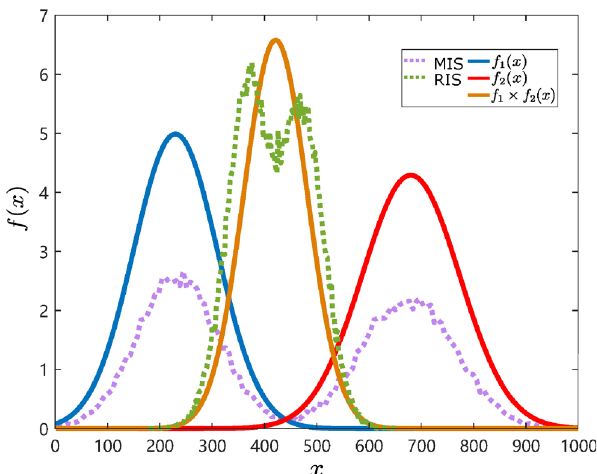
Fig. 6 Comparison of multiple importance sampling and RIS for the product f 1 f 2 of two functions. The RIS produces a result much closer to the target product than MIS.